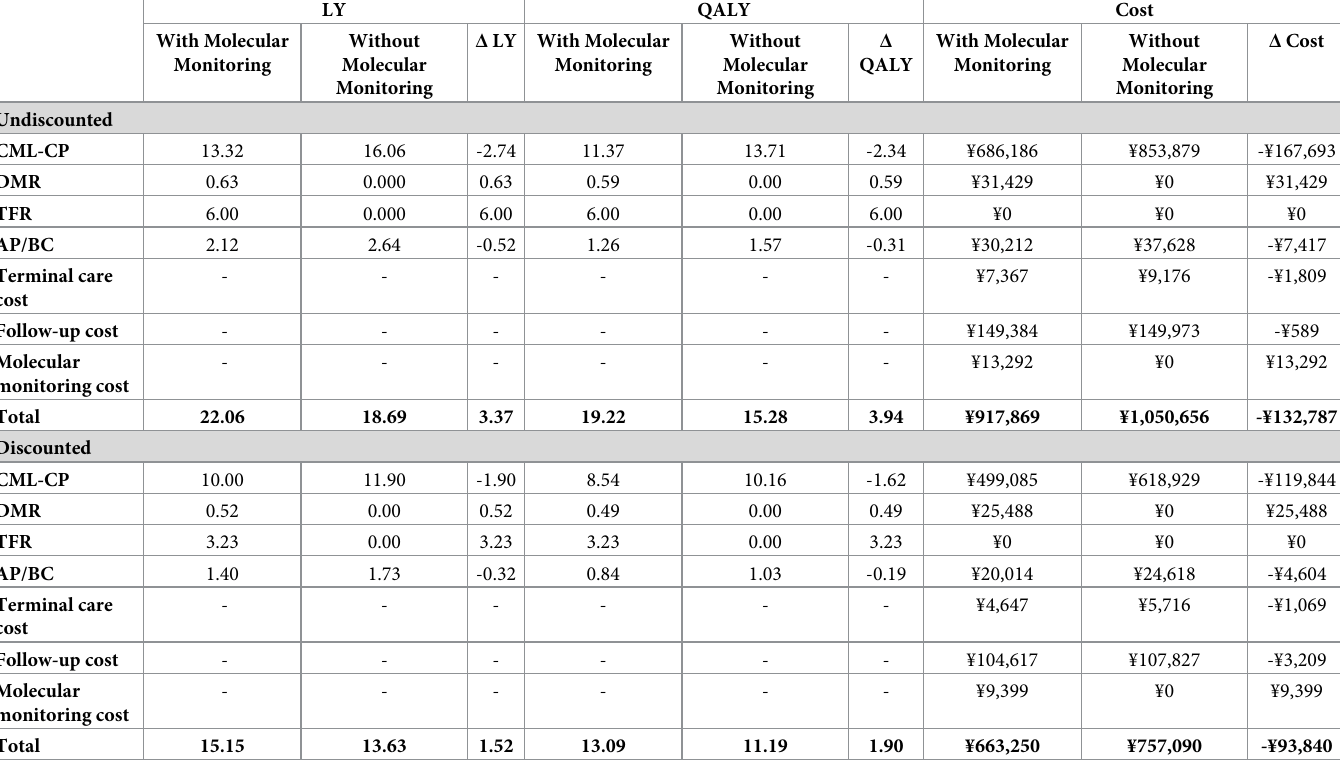
Table 4. Base case analysis results by health